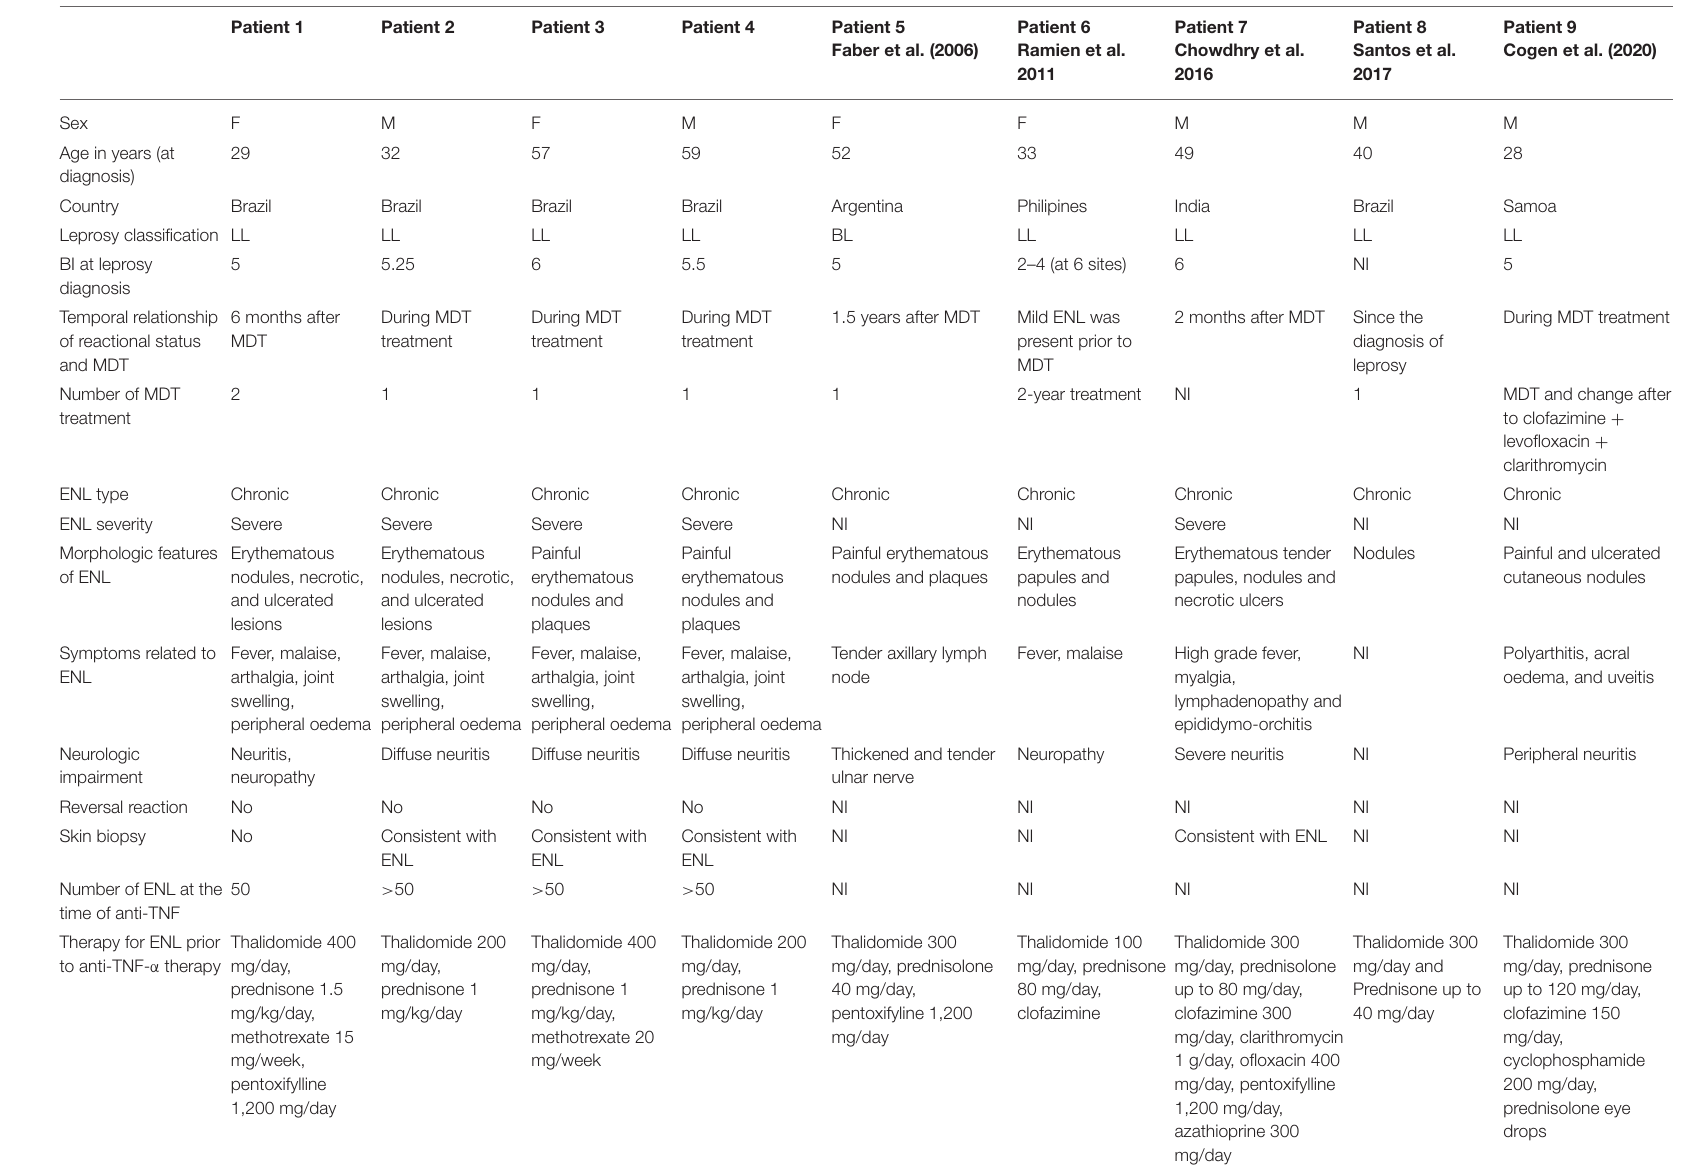
TABLE 1 | Demographic and clinical data of leprosy patients with severe, chronic and refractory ENL ( n = 4 patients), and cases already published ( n = 5 patients)